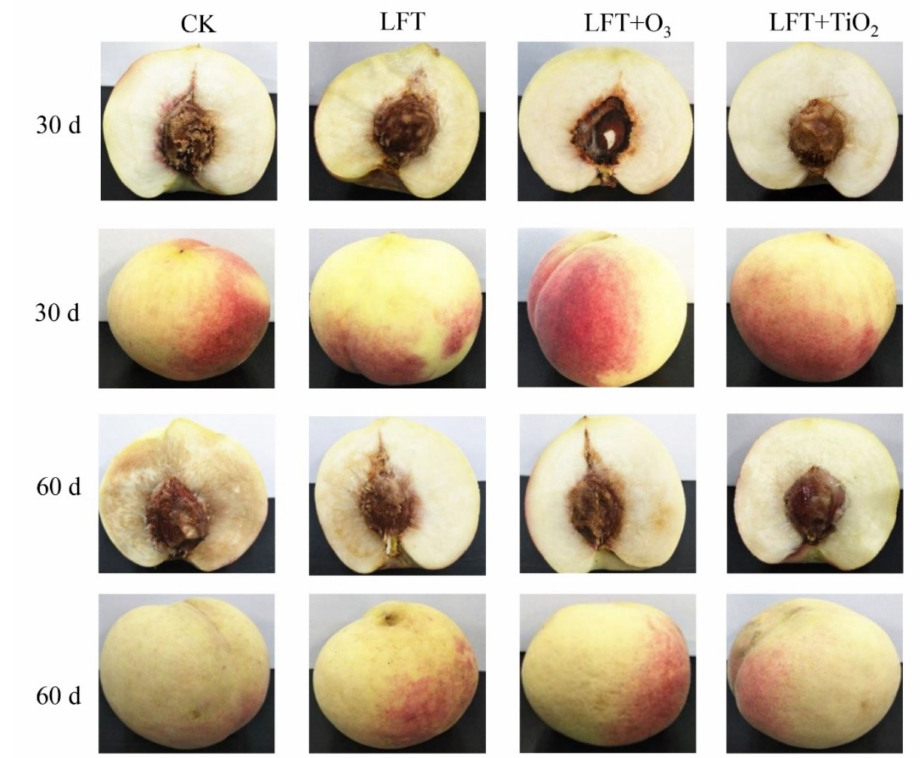
Figure 3. E ff ect of control (CK), LFT, LFT combined with ozone treatment (LFT + O 3 ) and LFT combined with TiO 2 photocatalysis (LFT + TiO 2 ) treatments on the appearance and longitudinal section photos of peach fruit after storage of 30 and 60